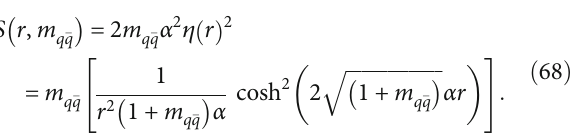
Þ , against ( r , m ) for speci fi c values of m q (cid:1) q q (cid:1) q